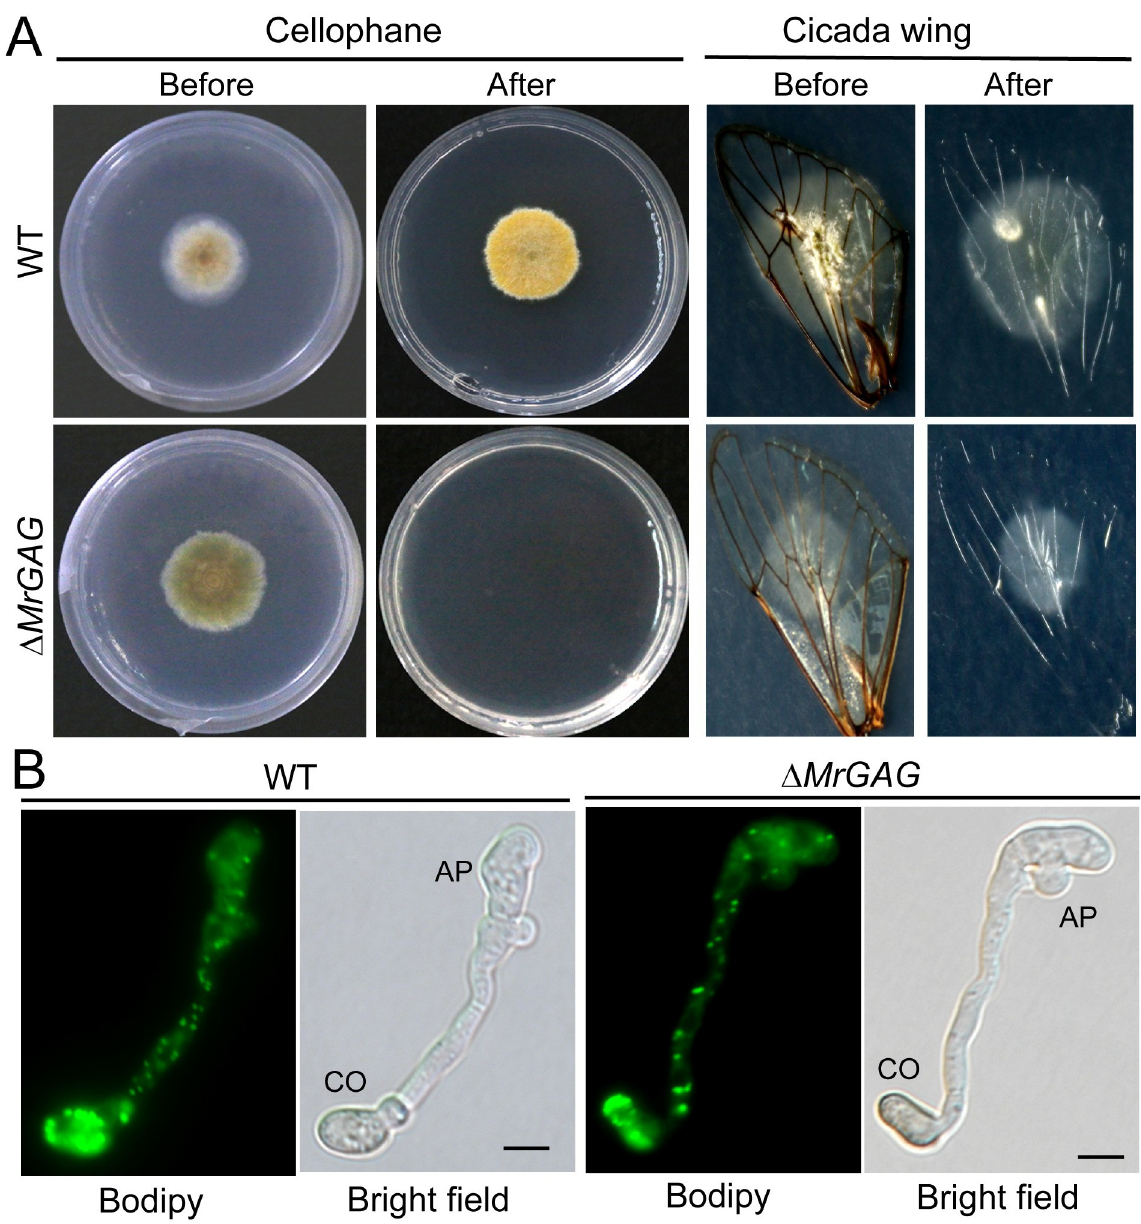
Fig 6. Penetration and appressorium formation assays. (A) Fungal penetration assays. Both the WT and Δ MrGAG were inoculated on cellophane membrane for three days or cicada wings for 40 hrs. The membrane and insect wings were then carefully removed with fungal cultures, and the plates were kept for incubation for another one week before photographing. (B) Appressorium formation and lipid-droplet utilization by WT and Δ MrGAG . Appressorium were induced on hydrophobic surfaces for 18 hrs and stained with the fluorescent dye Bodipy. CO, conidium; AP, appressorium. Bar, 5 μ